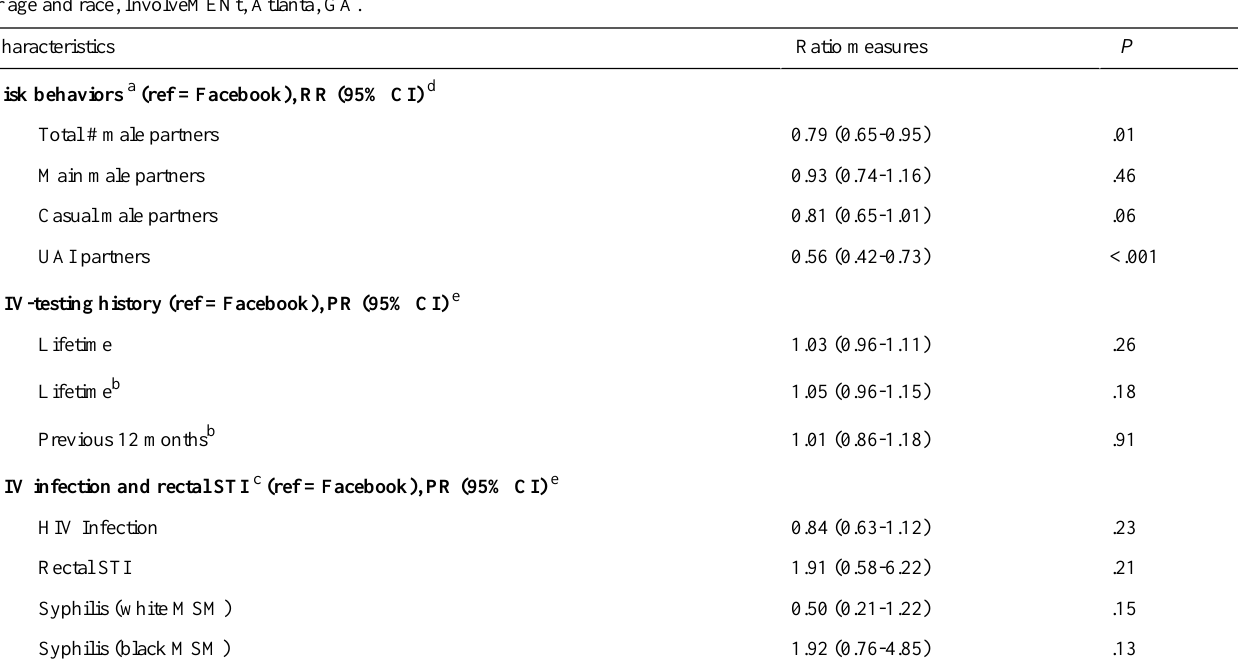
Table 5. Adjusted multivariate models for risk behaviors, testing, and infections at baseline by recruitment type (Facebook vs Atlanta Venues) adjusting for age and race, InvolveMENt, Atlanta, GA.